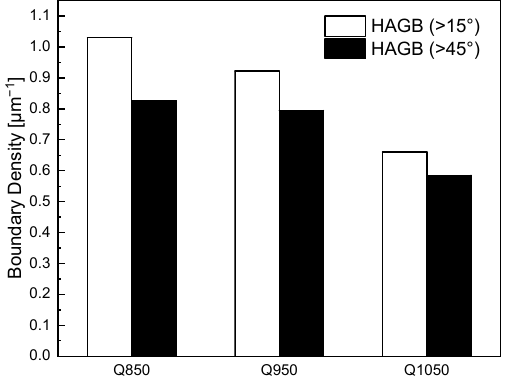
Figure 2. The density of HAGBs in three experimental samples.